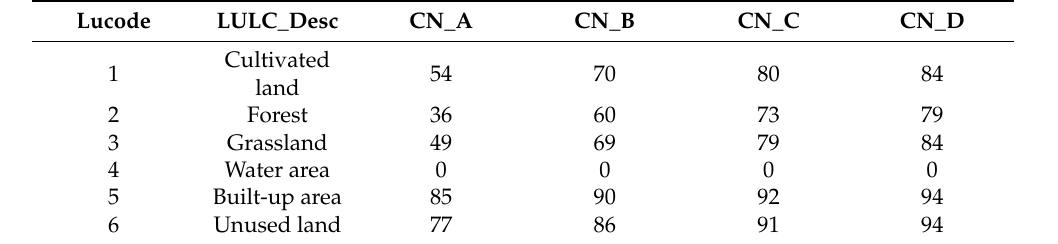
Table 3. FM coefficient